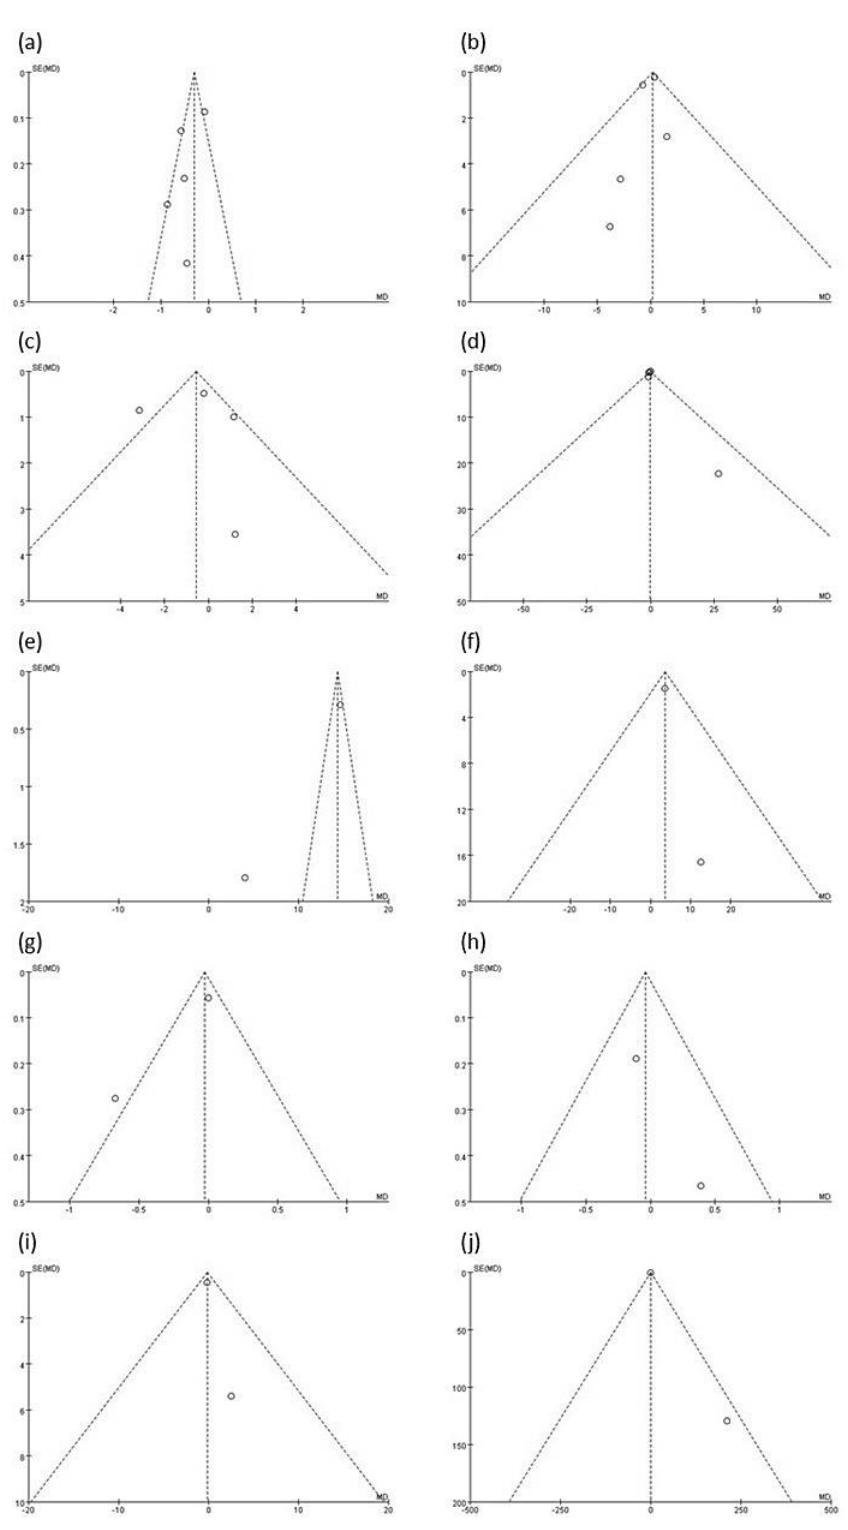
Figure 7. Funnel plots of included studies: ( a ) TNF −α , ( b ) IL − 6, ( c ) IL − 8, ( d ) IL − 10, ( e ) IFN −γ , ( f ) salivary IgA, ( g ) IL −1β , ( h ) IL − 2, ( i ) IL − 4, and ( j ) CRP.